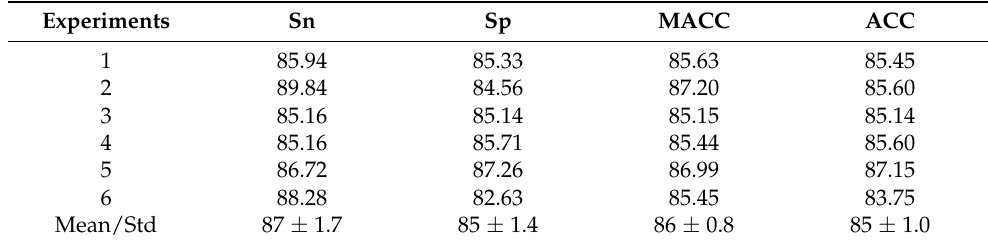
Table 2. Results and statistics verified by 6 experiments (%).